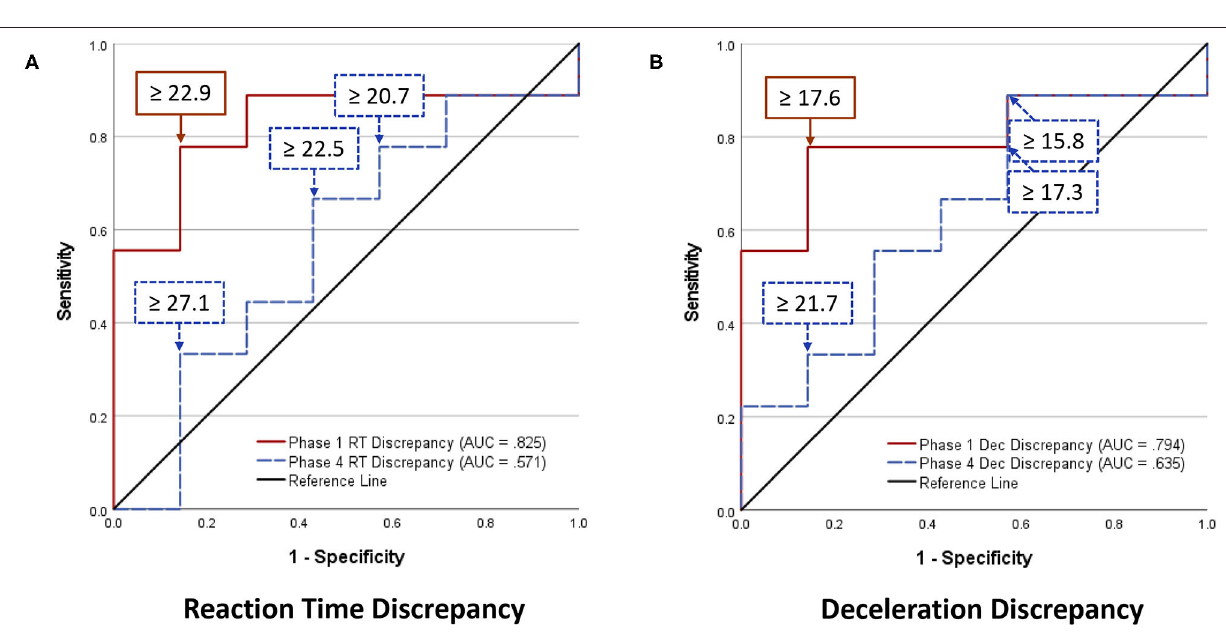
and Excursion 4-Mode Average. Conversion of